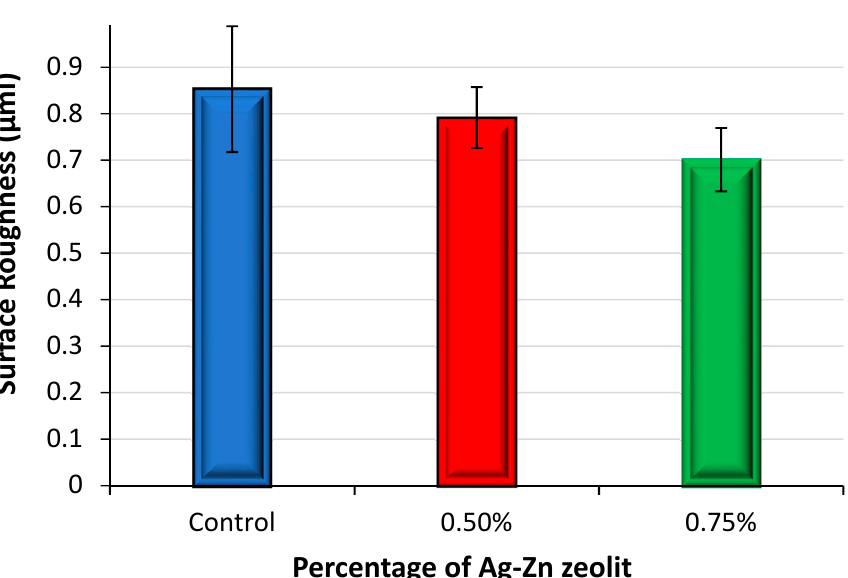
Figure 5. Bar chart showing mean values of surface roughness in the CC acrylic resin incorporated with Ag-Zn zeolite at different concentrations (0.50 wt.% and 0.75 wt.%) and without any Ag-Zn zeolite (control group).